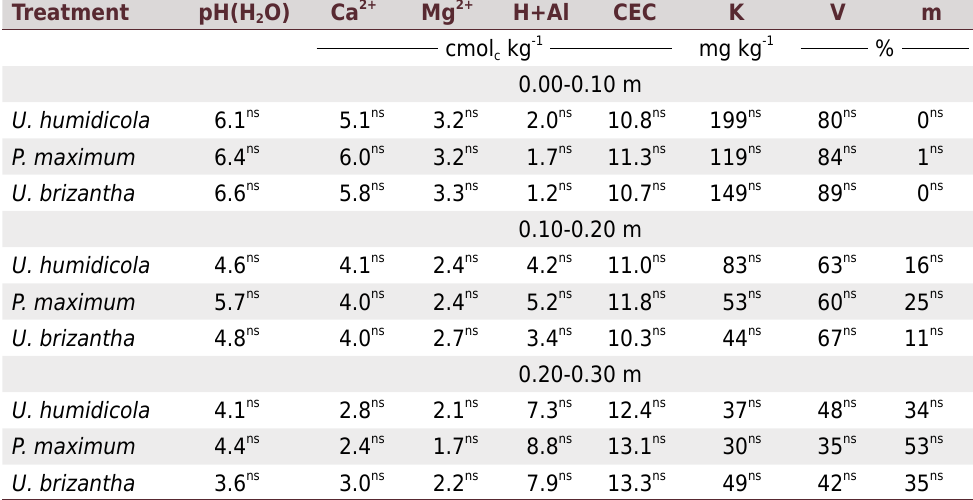
Table 2. Chemical characterization of the constructed minesoil revegetated with grasses in the 0.00-0.10, 0.10-0.20, and 0.20-0.30 m layers, after 58 months